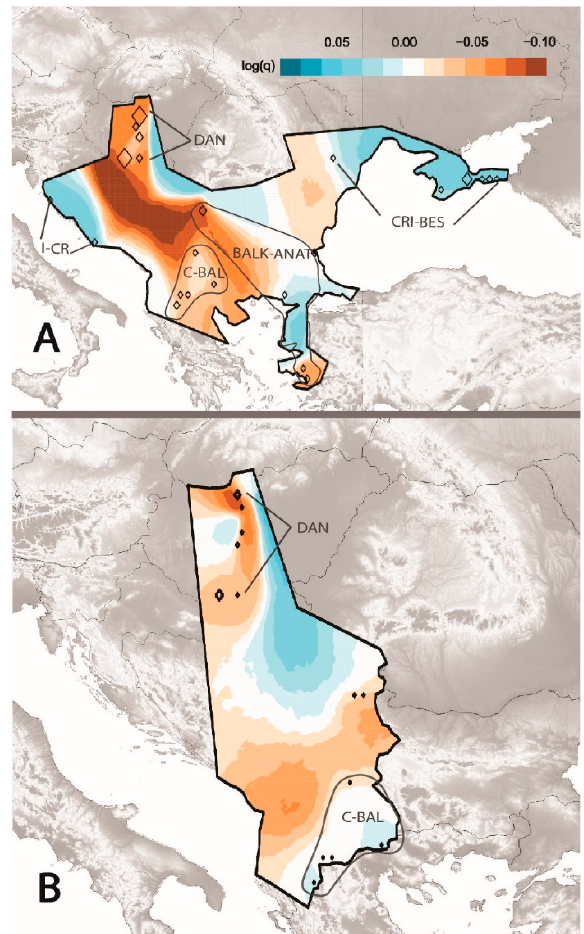
Figure 3. Effective migration patterns from the total dataset ( A ) and from Central Europe ( B ). Diamond ‐ shaped symbols represent samples, and size is proportional to the number of individuals. Higher ‐ than ‐ average (blue) and lower ‐ than ‐ average (brown) effective migration rates between sampling locations are shown.